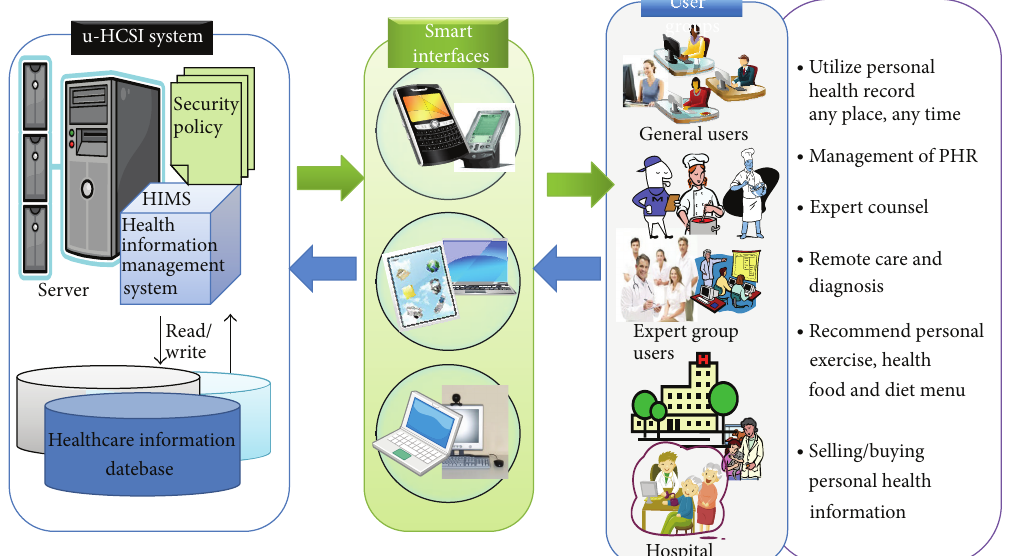
Figure 8: The framework of u-HCSIP (u-healthcare service integration platform).